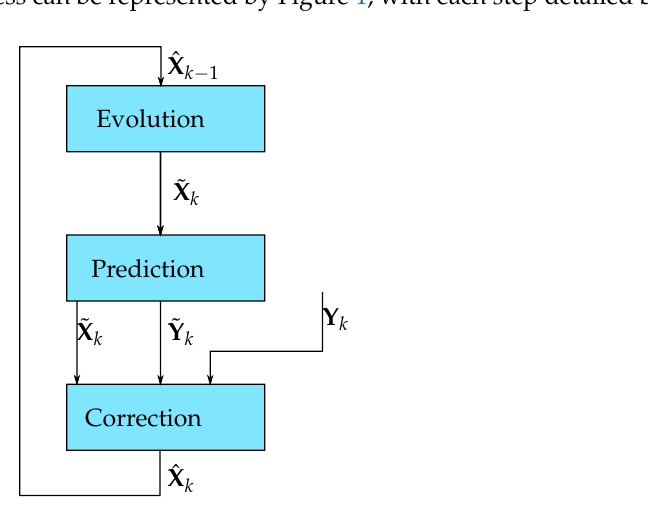
Figure 1. The Kalman filter recursive